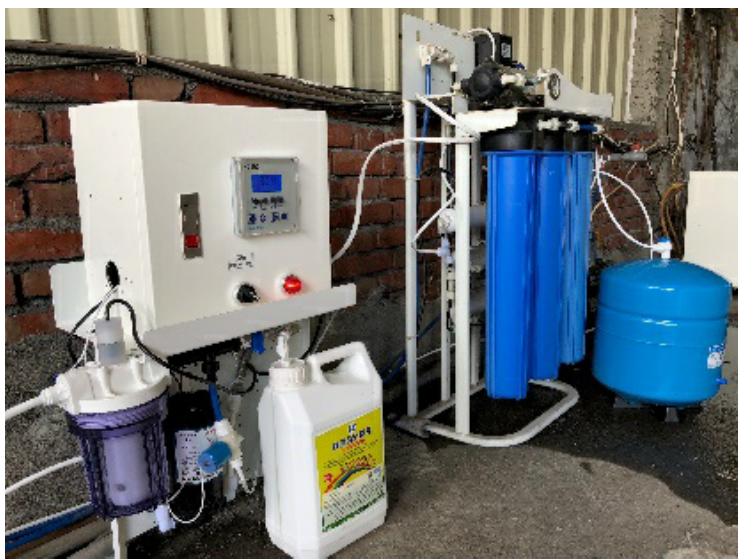
Figure 5. Fully installed water purification and disinfectant system.